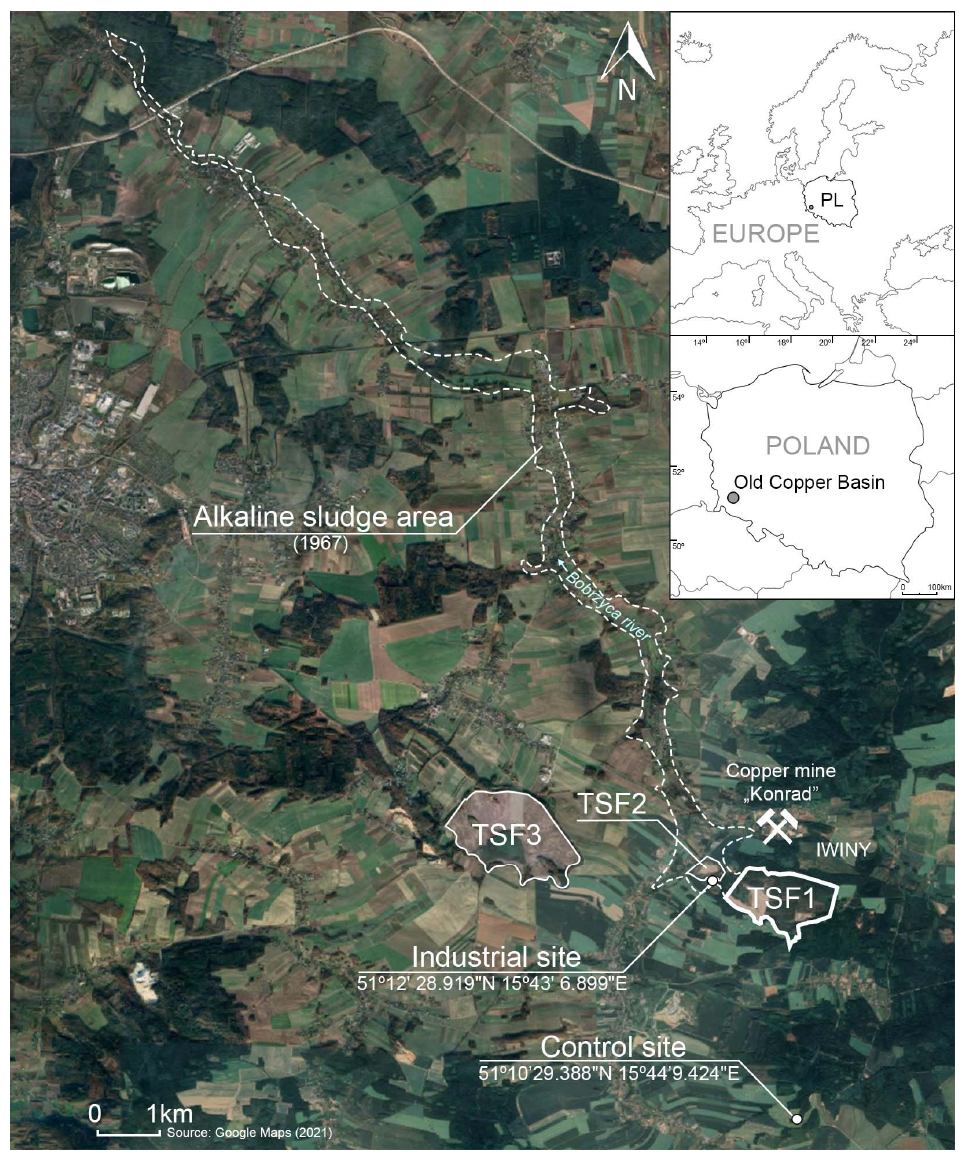
Figure 1. Location of study plot: Industrial (Ind.) and Control site and tailings storage facilities (TSFs) in so-called Old Copper District, Poland. The 1967 leakage area is presented on the basis of materials from the State Archive in Wroc ł aw, Boles ł awiec Branch [53].